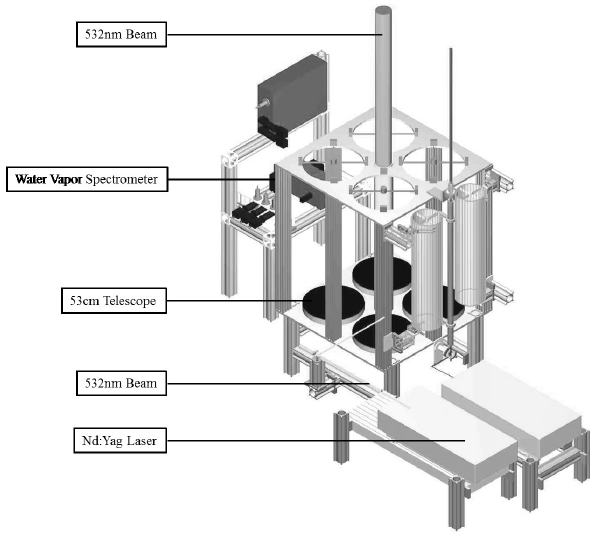
Fig. 1. Representation of the lidar instrument at Reunion Island uni- versity during the 2002–2005 period. Figure 1. Representation of the lidar instrument at Reunion Island university during the 2002- 3 2005 period. 4